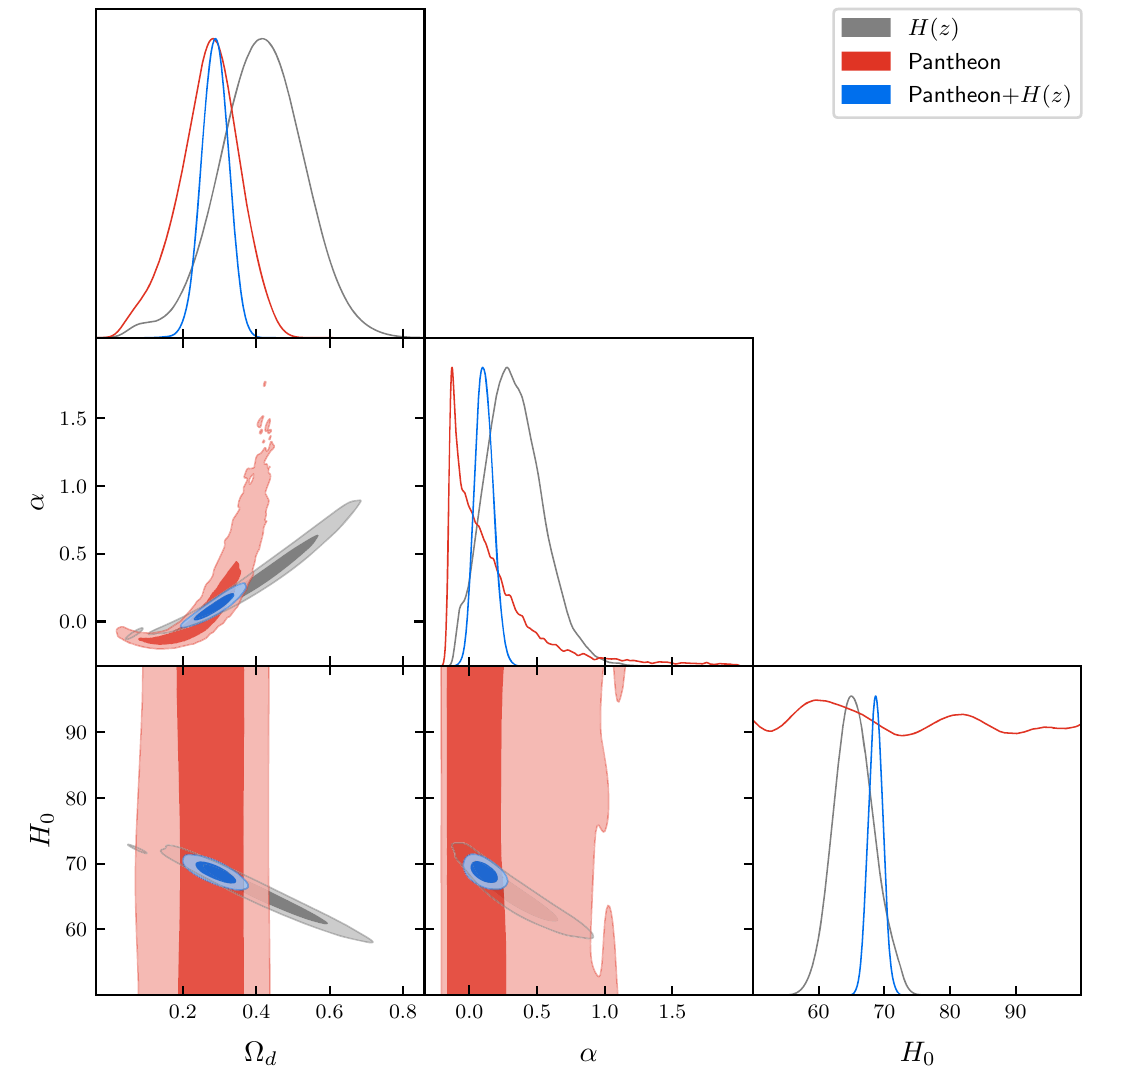
Fig. 3 All constraints (SNe Ia and H ( z ) ) on (cid:4)( t ) CDM